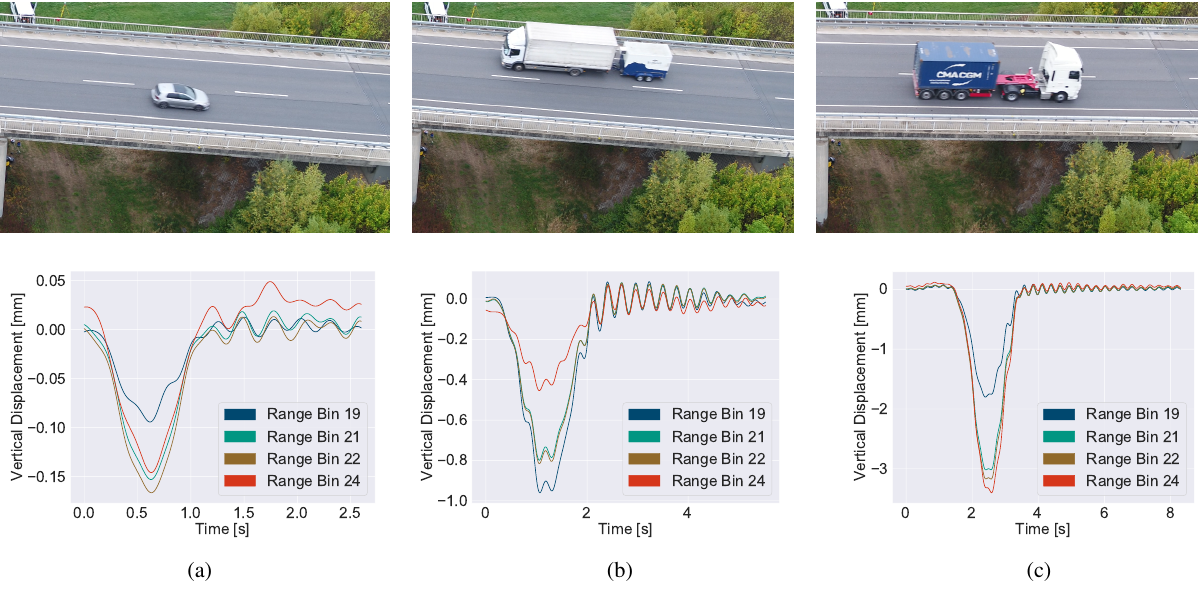
Figure 4. Different events on bridge A with their resulting time-series signals of the measured displacements. First row: UAV-images of vehicles crossing the bridge. Second row: the corresponding displacement time-series.